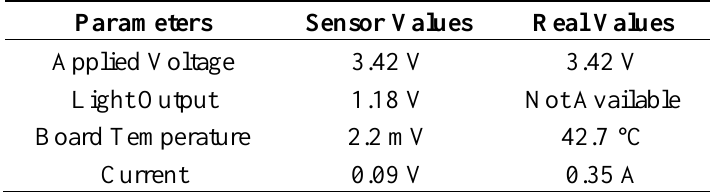
Table 1. Mean Sensor readings when LED is operating